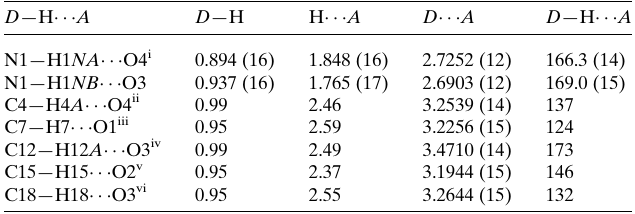
Table 3 Hydrogen-bond geometry (A˚ , (cid:4) ) for III .